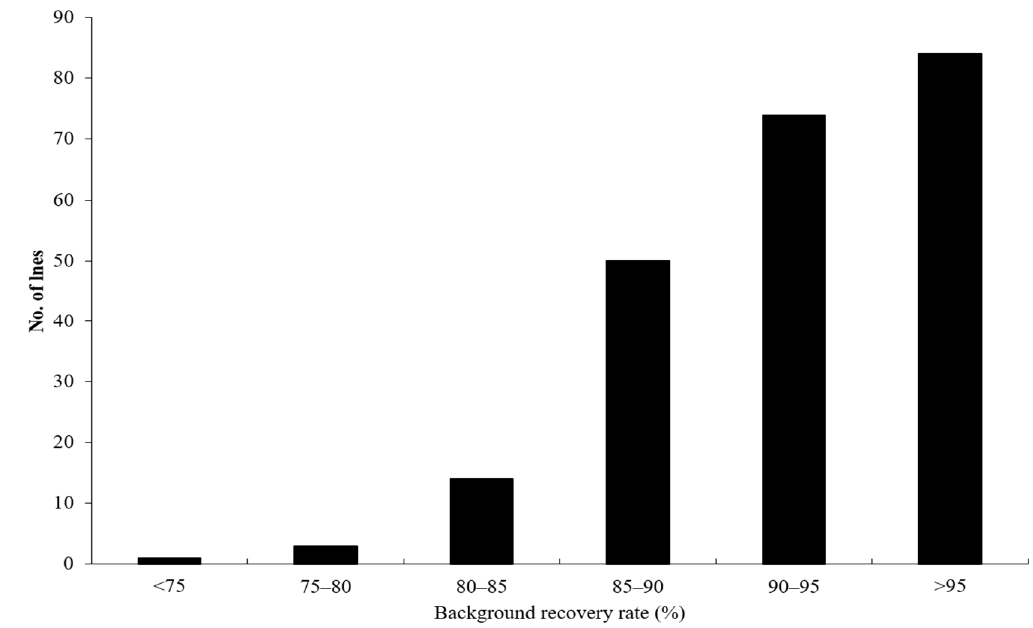
Figure 1. The genetic background recovery rate of the introgression line population.